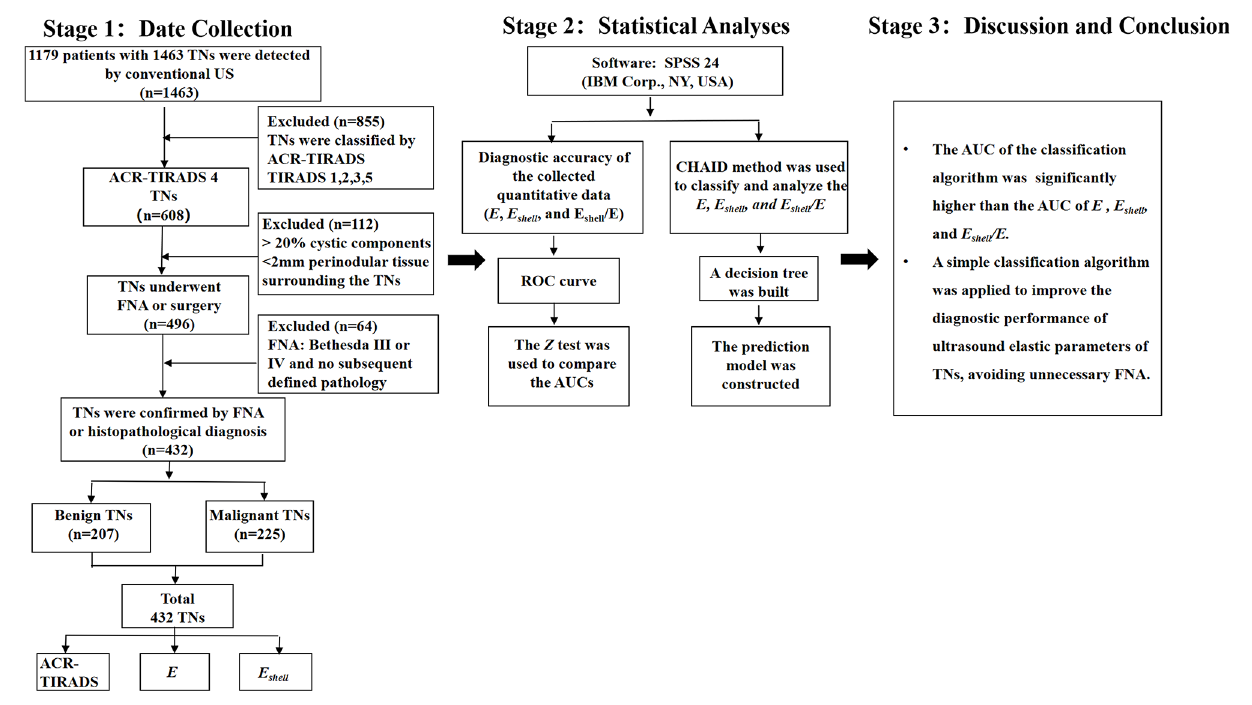
FIGURE 1 | Flowchart of the